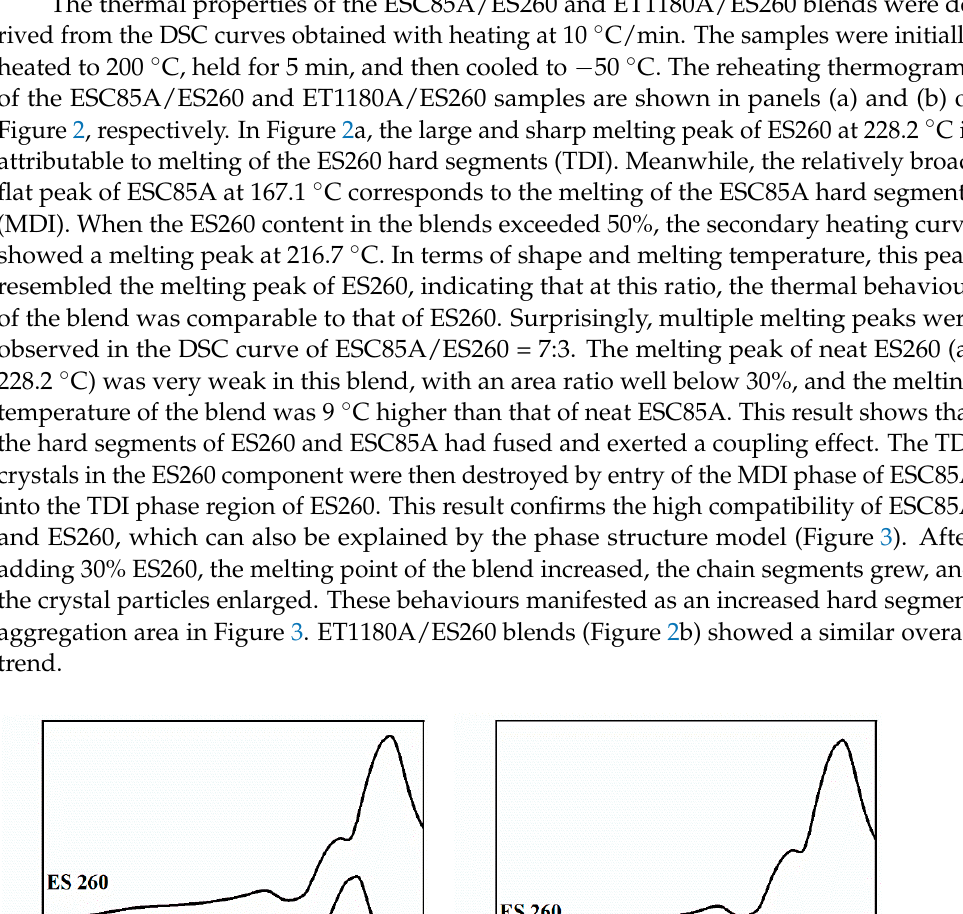
Figure 3. The microstructure and structure evolution of neat TPU and TPU blends. ( a ) ES260 containing TDI with a hard segment content of 33% (black), ESC85A containing MDI with a hard segment content of 33% (red). In the blend system, the aggregation structure of the two kinds of chains rearranges at the molecular level. The hard segment domain of the ESC85A/ES260 blend comprises both ESC85A and ES260 hard segments, forming new phase separation structures with larger phase region distances; ( b ) ES260 containing TDI with a hard segment content of 33% (black), ET1180A containing MDI with a hard segment content of 25% (yellow). A relatively lower compatibility of the hard domains of the ET1180A/ES260 blend, though mutually integrated to some extent, still partly maintain their respective micro domains.